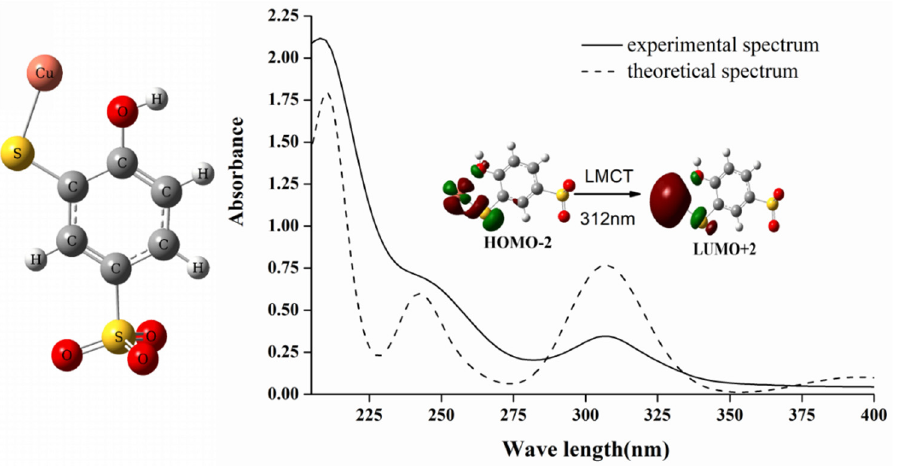
Figure 3. Theoretical model of TCAS-Cu complex ( left ), and experimental and theoretical UV absorption spectrum of TCAS-Cu complex ( right ).